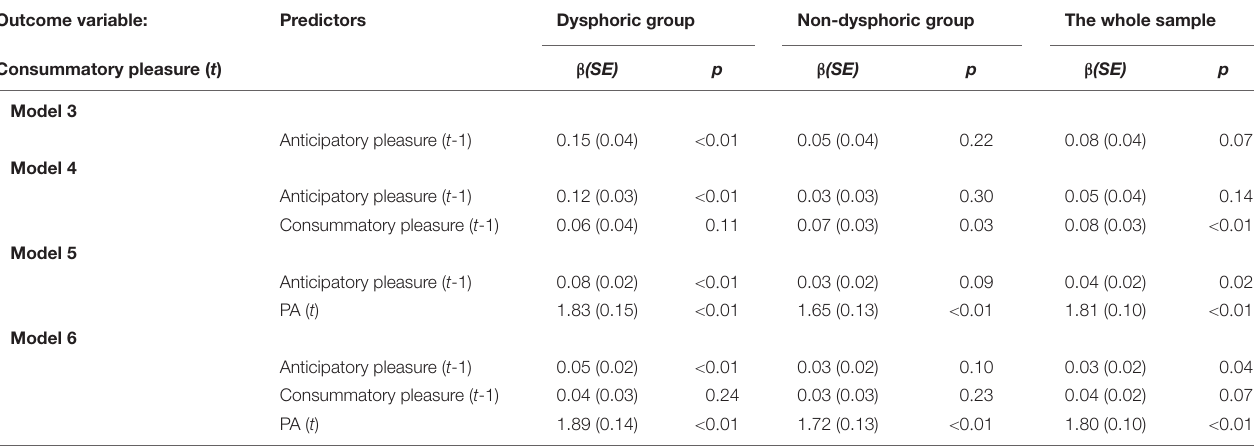
TABLE 3 | Multilevel analyses of the time-lagged associations between consummatory pleasure, anticipatory pleasure and positive affect (PA) in dysphoric and non-dysphoric groups respectively and as a whole sample. Outcome variable: Predictors Dysphoric group Non-dysphoric group The whole sample Consummatory pleasure ( t ) β